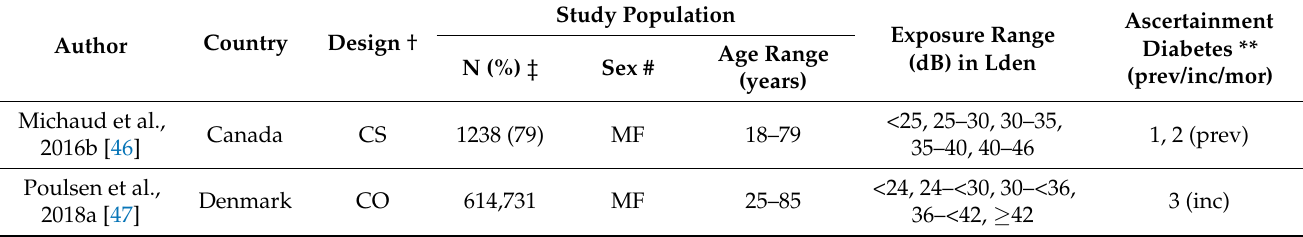
Table 5. Overview of the characteristics of the selected studies on the association between WT sound and